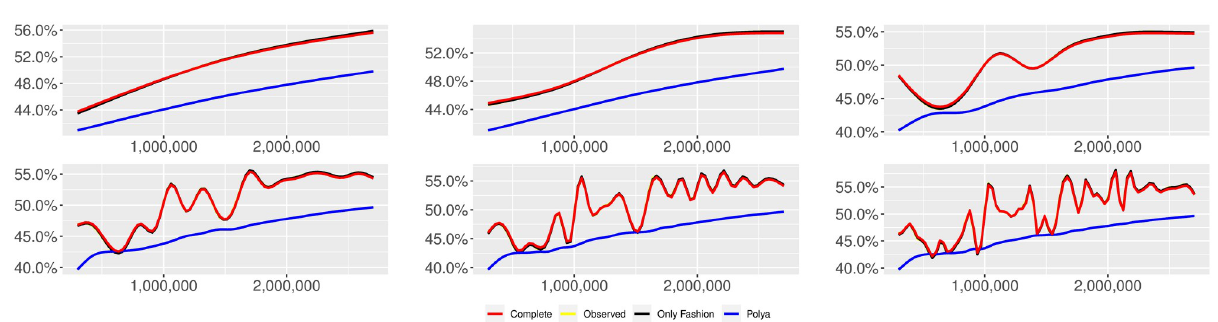
Fig 22. “Covid” ( T = 0, entire, D = 3 0 , S = 100 slots of equal size): Sentiment curves. In each panel, the yellow line is the cubic spline smoothing of the time series of the observed tweets ξ n +1 , together with the default confidence interval (gray), the red line represents the cubic spline smoothing of the time series of the estimated predictive means ^ c (defined in Subsec. 3.2), obtained with the complete RP model, the black and the blue lines provide n similar approximations obtained with the other models: black = Only fashion RP model and blue = Standard Po´lya model. In each panel, the smoothing is obtained with a given number of nodes: k = 3 (top left panel), 5 (top middle panel), 10 (top right panel), 20 (bottom left panel), 30 (bottom middle panel), 50 (bottom right panel).